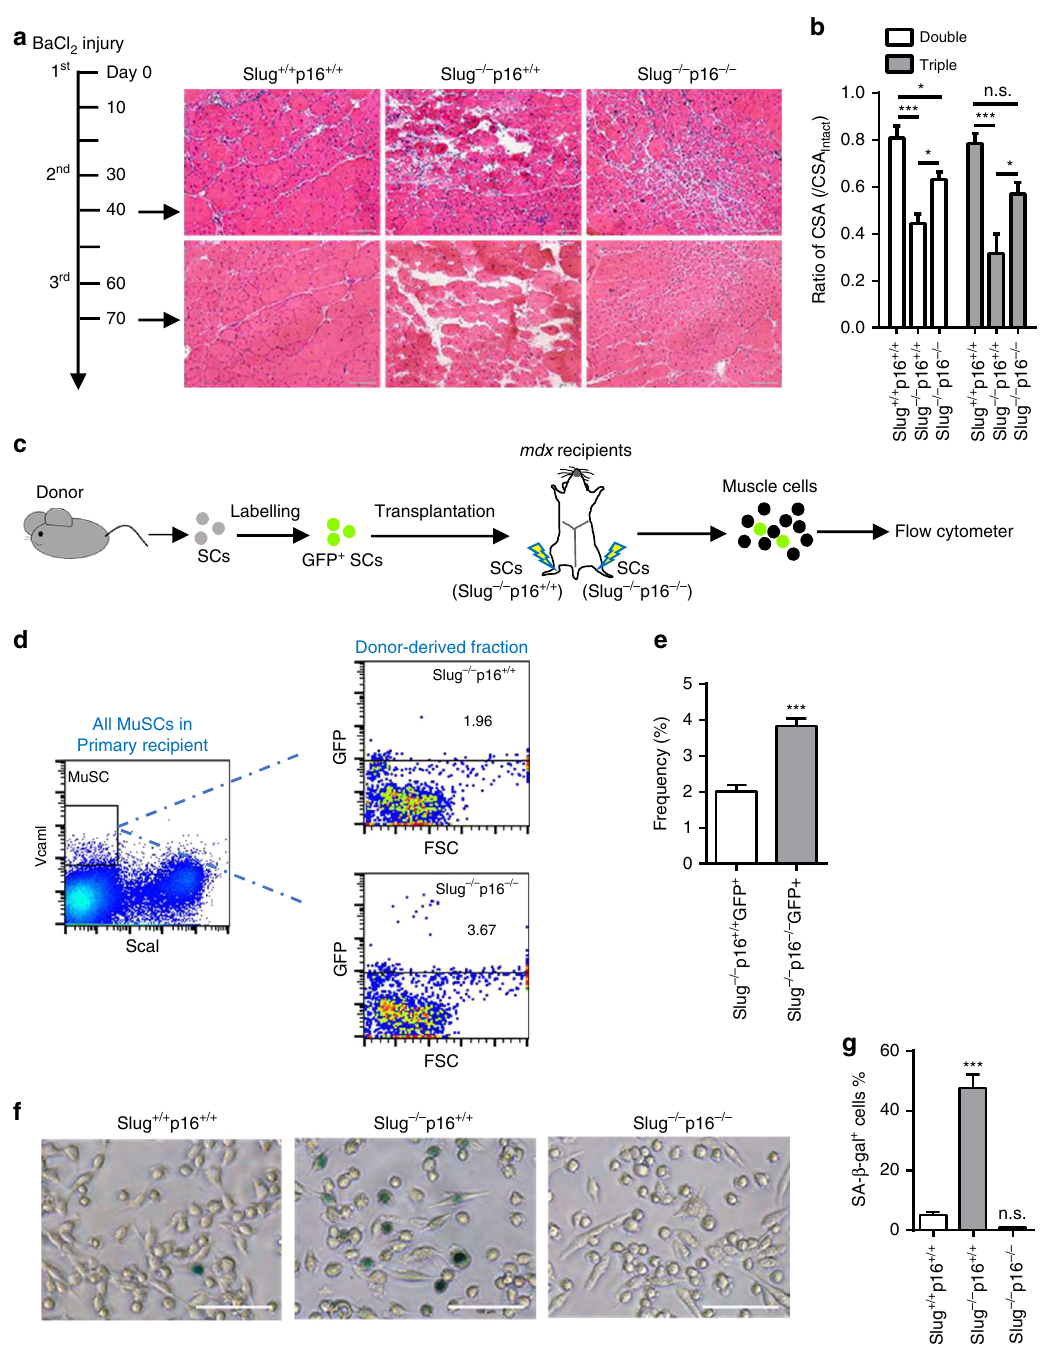
Fig. 6 Removal of p16 Ink4a partially rescues regeneration and self-renewal of Slug -de fi cient SCs. a H&E staining of the double and triple BaCl 2 -injured TA muscles from Slug + / + p16 + / + , Slug − / − p16 + / + , and Slug − / − p16 − / − mice ( n = 3 – 6 mice per group). Left panel, the diagram for consecutive injury. Right panel, representative images of H&E staining of muscle tissue sections from injured mice. Scale bar, 100 μ m. b Ratio of myo fi ber CSA in the intact and BaCl 2 -injured TA muscles between Slug + / + p16 + / + , Slug − / − p16 + / + , and Slug − / − p16 − / − mice. * p < 0.05, *** p < 0.001 by one-way ANOVA; n.s. not signi fi cant. c Scheme of SC transplantation. SCs isolated from Slug − / − p16 + / + and Slug − / − p16 − / − mice were infected with GFP-expressing retroviruses, and injected into either side of the BaCl 2 -pre-injured TA muscle of mdx recipient, respectively. Total mononucleated muscle cells were isolated separately from either TA muscle 4 weeks after transplantation, and subjected to fl ow cytometric analysis for the fraction of donor-derived SCs (GFP + ) in MuSC (CD45 − CD31 − Sca1 − Vcam I + ) subpopulation of recipient mice. d Representative fl ow cytometry plots showing the frequency of donor-derived SCs (GFP + ) within the total recipient MuSC (CD45 − CD31 − Sca1 − Vcam I + ) subpopulation in mononucleated TA muscle cells. e Percent of donor-derived cells (GFP + ) in total MuSC (CD45 − CD31 − Sca1 − Vcam I + ) subpopulation of mononucleated TA muscle cells from mdx recipients ( n = 4 – 6). *** p < 0.001 by student ’ s t -test. f Representative SA- β -Gal staining of cultured primary SC-derived myoblasts. 10 4 SCs of indicated genotype were plated in Matrigel-coated wells of 24-well plate, and passaged weekly. Bright- fi eld imaging and SA- β -Gal staining were performed in cells on day 7 of culture at passage 3. Scale bar, 100 µ m. g Percentage of the SA- β -Gal + cells in serially passaged myoblasts on day 7 of culture at passage 3. *** p < 0.01; by student ’ s t -test. n.s. not signi fi cant. Data are shown as mean ± SEM of three independent replicates. Source data are provided as a Source Data fi